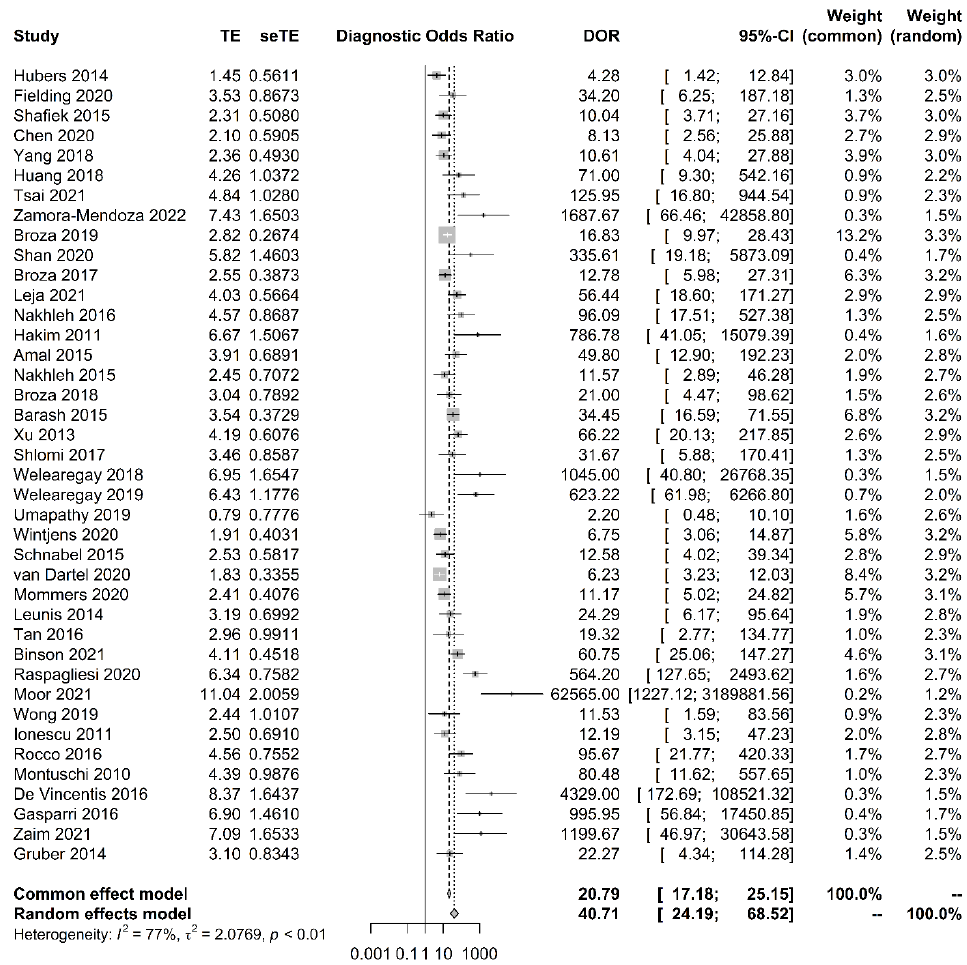
Figure 2. Summary receiver operating characteristic curve graph of the included studies. The accu- racy using all data was higher than that of the test set.